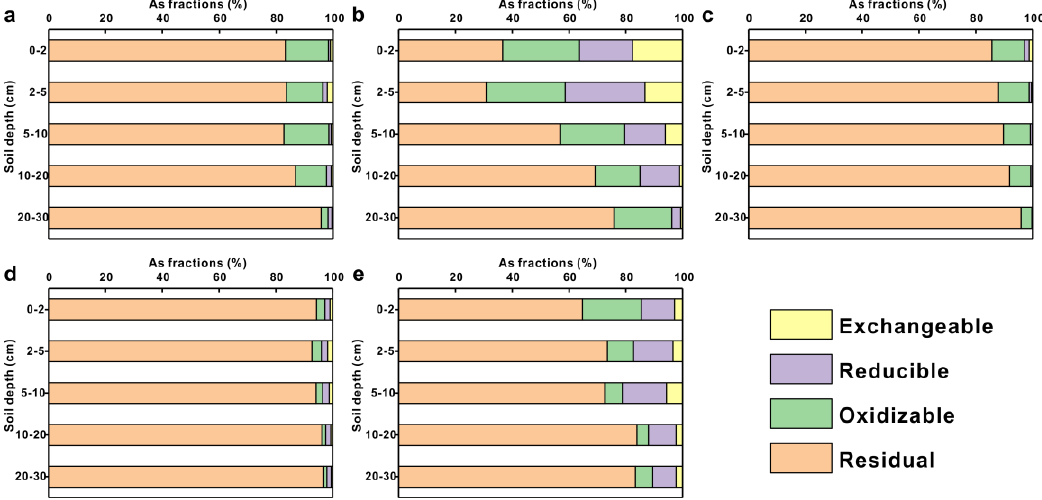
Figure 8. Percentage of exchangeable, reducible, oxidizable, and residual fractions of total As in soil profiles under different preservative – treated planks: ( a ) Background profile; ( b ) CCA-5; ( c ) ACQ-3; ( d ) CA-6; ( e ) CCA plus CA-3.